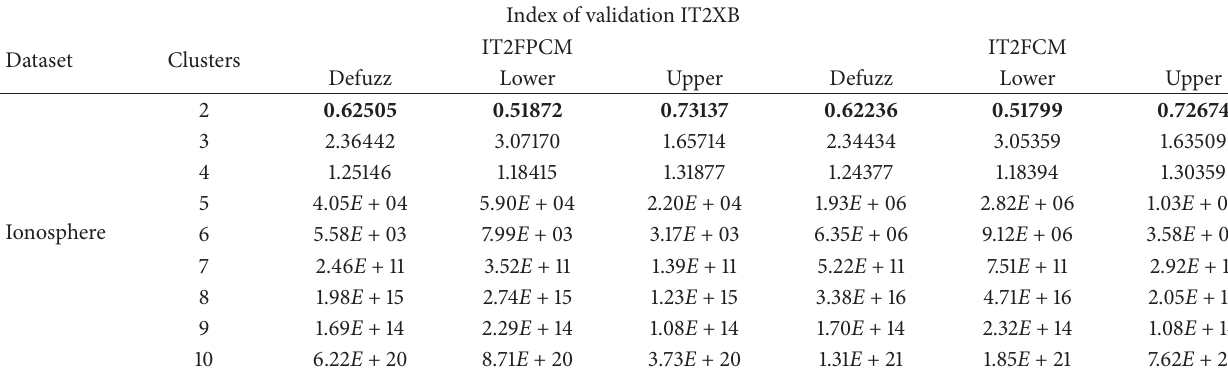
Table 15: Results of the IT2XB validation index to Ionosphere dataset clustering using IT2FPCM and IT2FCM algorithm with 𝑚 = [1.5, 2.5] and 𝜂 = [1.5, 2.5] as